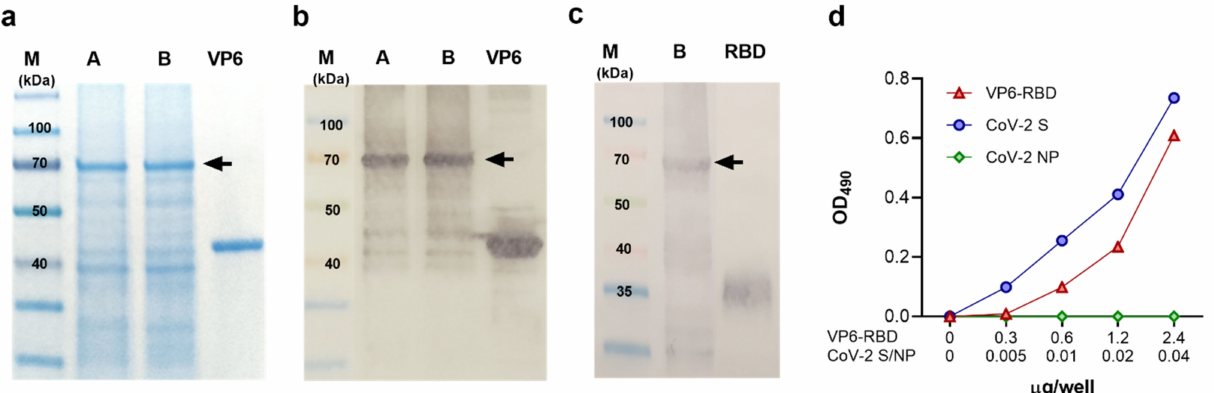
Figure 1. Characterization of VP6-RBD fusion protein. Rotavirus VP6 protein was used as a backbone to generate fusion protein (FP) carrying SARS-CoV-2 Spike (S) protein derived receptor-binding domain (RBD) as described in the Materials and Methods. The FP was crude purified from Sf9 insect cell pellets after 6-day culture with recombinant baculovirus and separated (5 µ g/lane of total protein) under reducing conditions in SDS-PAGE following staining with Coomassie blue ( a ) or immunoblotting using primary antibodies against VP6 ( b ) or SARS-CoV-2 S protein ( c ). VP6-RBD FP (~70 kDa) before (A) and after (B) final clarification step is indicated by an arrow ( a – c ). Wild-type VP6 (~42 kDa) and commercial RBD protein (~23 kDa, migrating as a higher molecular weight due to glycosylation) were used as positive controls in SDS-PAGE and/or Western blot. Molecular weight marker (M) is shown with the respective molecular sizes (kDa). Binding of VP6-RBD, SARS-CoV-2 S (CoV-2 S, a positive control), and SARS-CoV-2 nucleoprotein (CoV-2 NP, a negative control) to immobilized human angiotensin-converting enzyme 2 (hACE2) by an ELISA-based binding assay ( d ). Optical density (OD) values at 490 nm of VP6-RBD (0–2.4 µ g/well), CoV-2 S, and NP (both 0–0.04 µ g/well) binding to 0.05 µ g/well hACE2 are